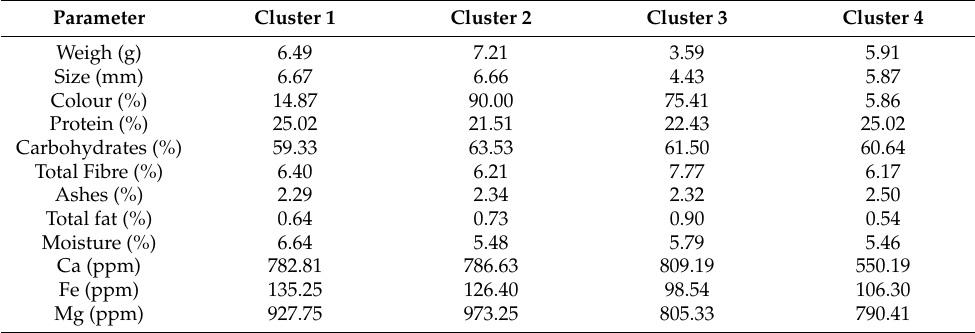
Table 8. Means of studied variables for each of the